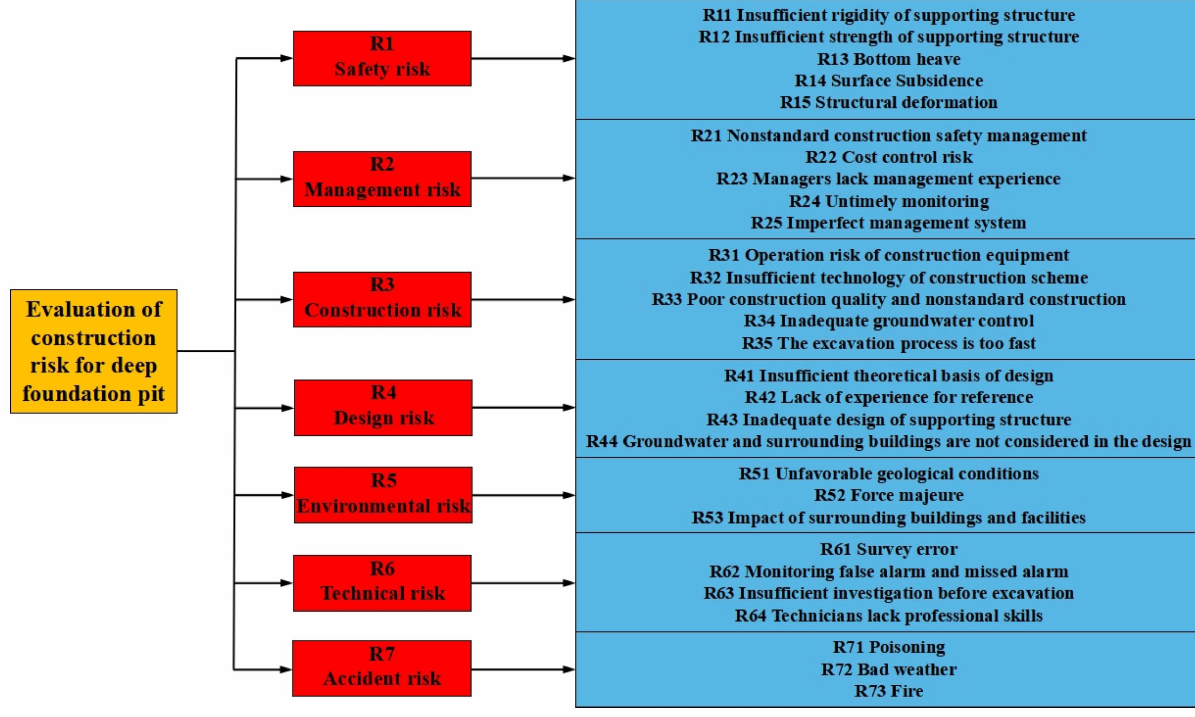
Figure 2. Risk evaluation indices of deep foundation pit construction.